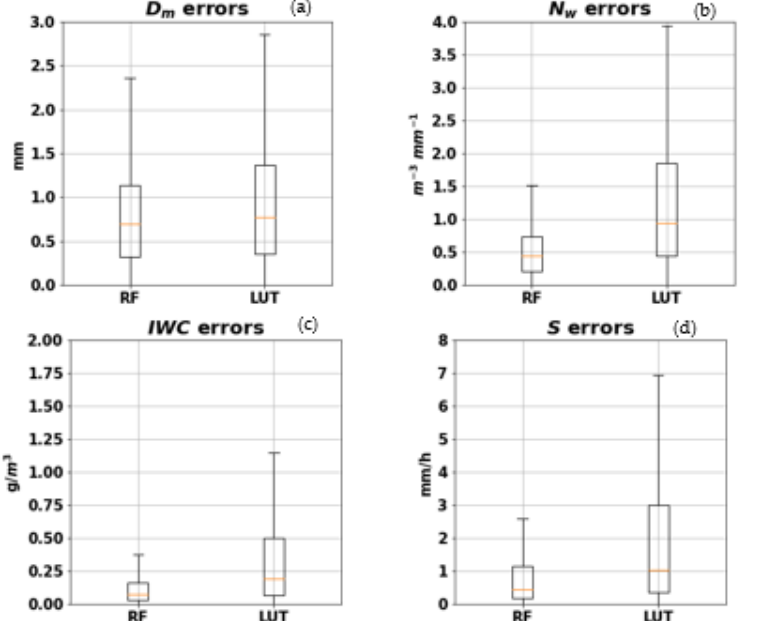
Figure 7. Boxplots (25, 50, and 75 percentiles) showing the absolute errors of the look-up table (LUT) and random forest (RF) method retrievals: ( a ) D m , ( b ) N w , ( c ) IWC, and ( d ) S, compared with PSD disdrometer measurements.